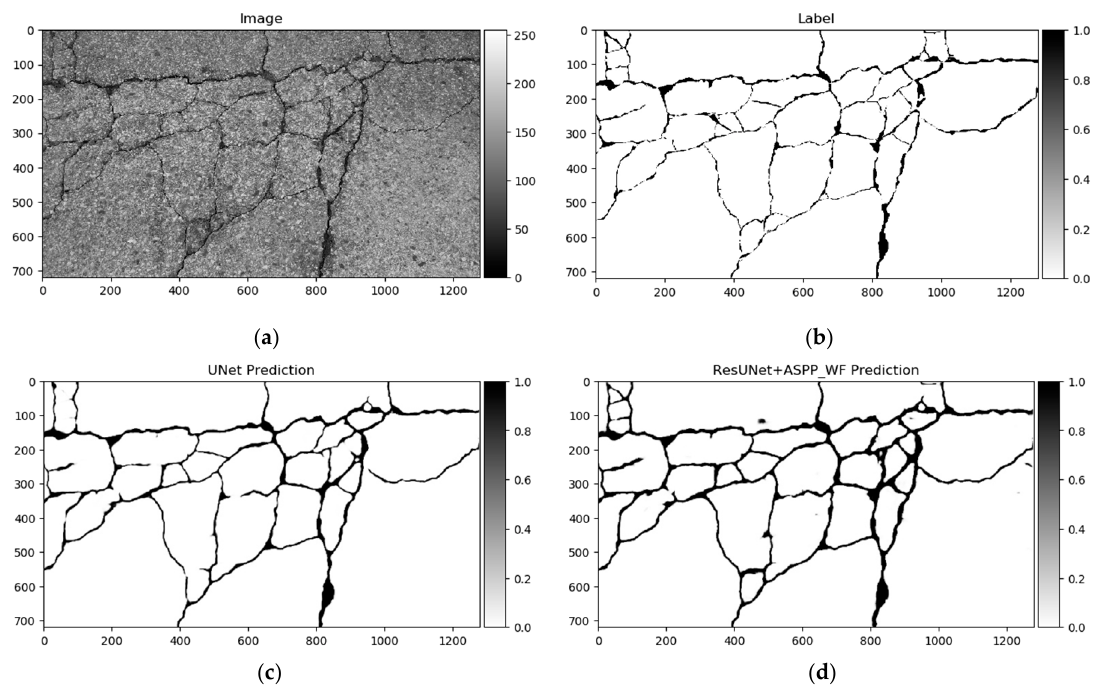
Figure 14. U-Net (baseline) and best-performing solution—ResU-Net + ASPP_WF predictions on Crack500 dataset sample. ( a ) Image, ( b ) label, ( c ) U-Net prediction, ( d ) ResU-Net + ASPP_WF prediction. Quality of continuous defect segmentation noticeable in whole image in predictions ( c , d ). ResU-Net + ASPP_WF segmented narrow pavement cracks.